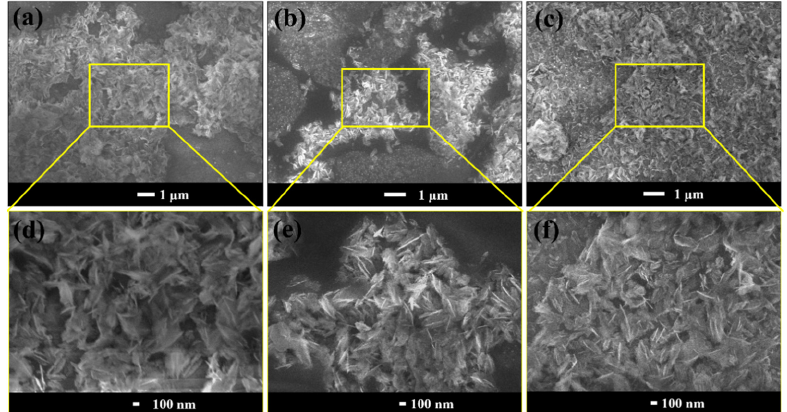
Figure 1. ( a – c ) Low-magnified and ( d – f ) high-magnified FE-SEM images of the AD-1, AD-2 and AD-3 samples,